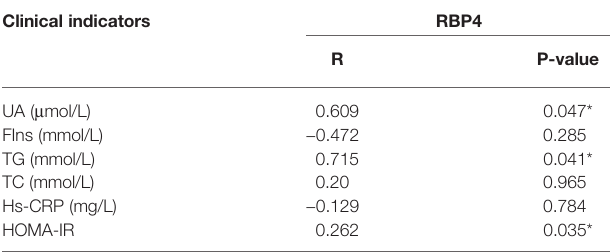
TABLE 4 | Correlation between plasma RBP4 and clinical indicators in HUA rats. Clinical